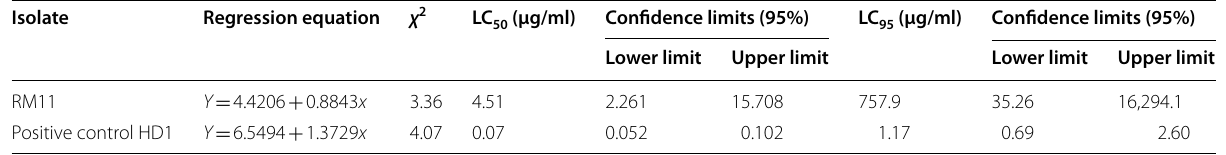
Table 2 Toxicity of Bacillus thuringiensis isolate RM11 to diamondback moth, Plutella xylostella larvae, in comparison with positive control HD1